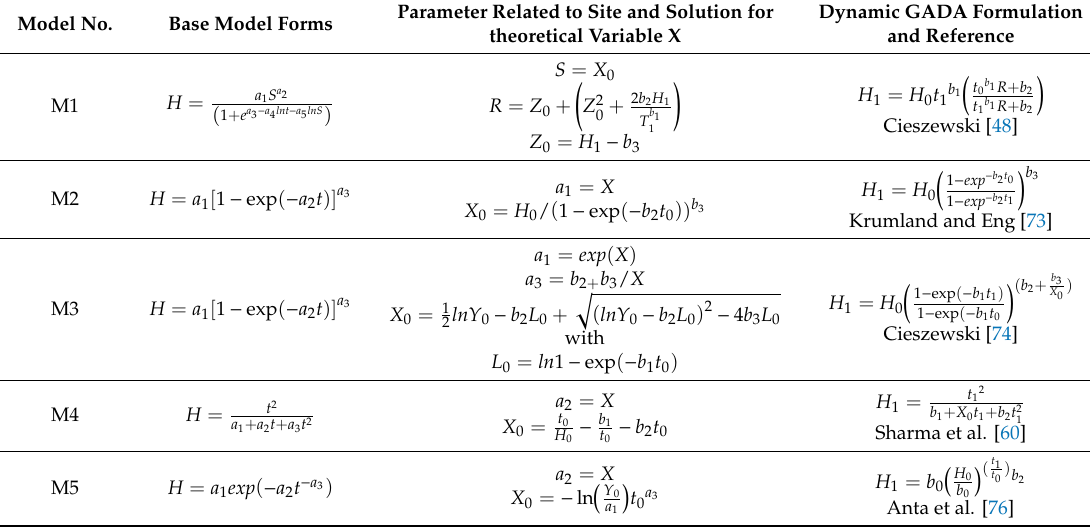
Table 2. The dynamic generalized algebraic di ff erence approach (GADA) formulations with base equations used to model dominant height